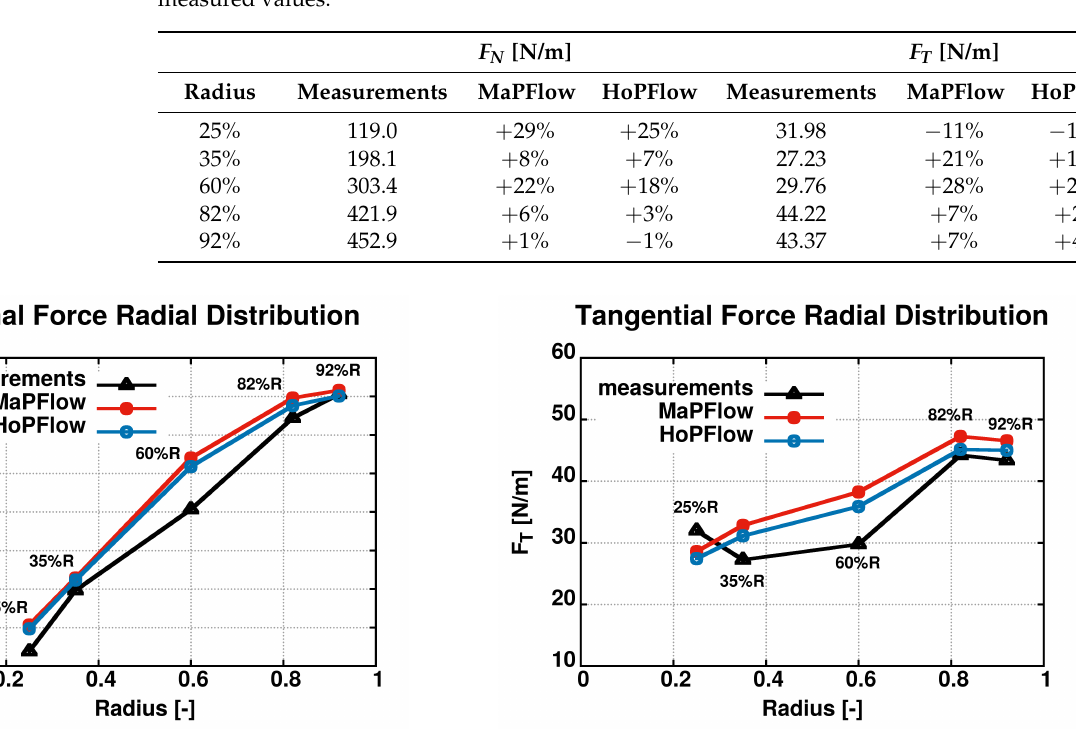
Figure 9. Radial distribution of normal and tangential forces. Comparison between experimental measurements and computational predictions.